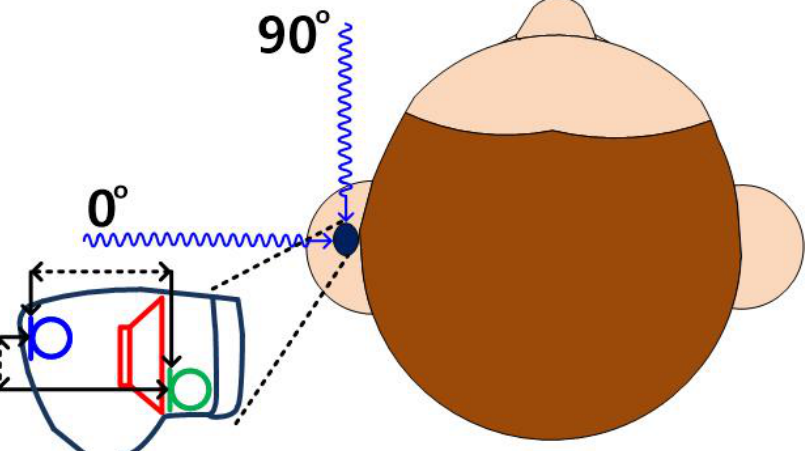
Figure 2. Dependency of causality constraint on the direction of noise source in in-ear headphones. Blue: reference microphone, Green: error microphone, Red: